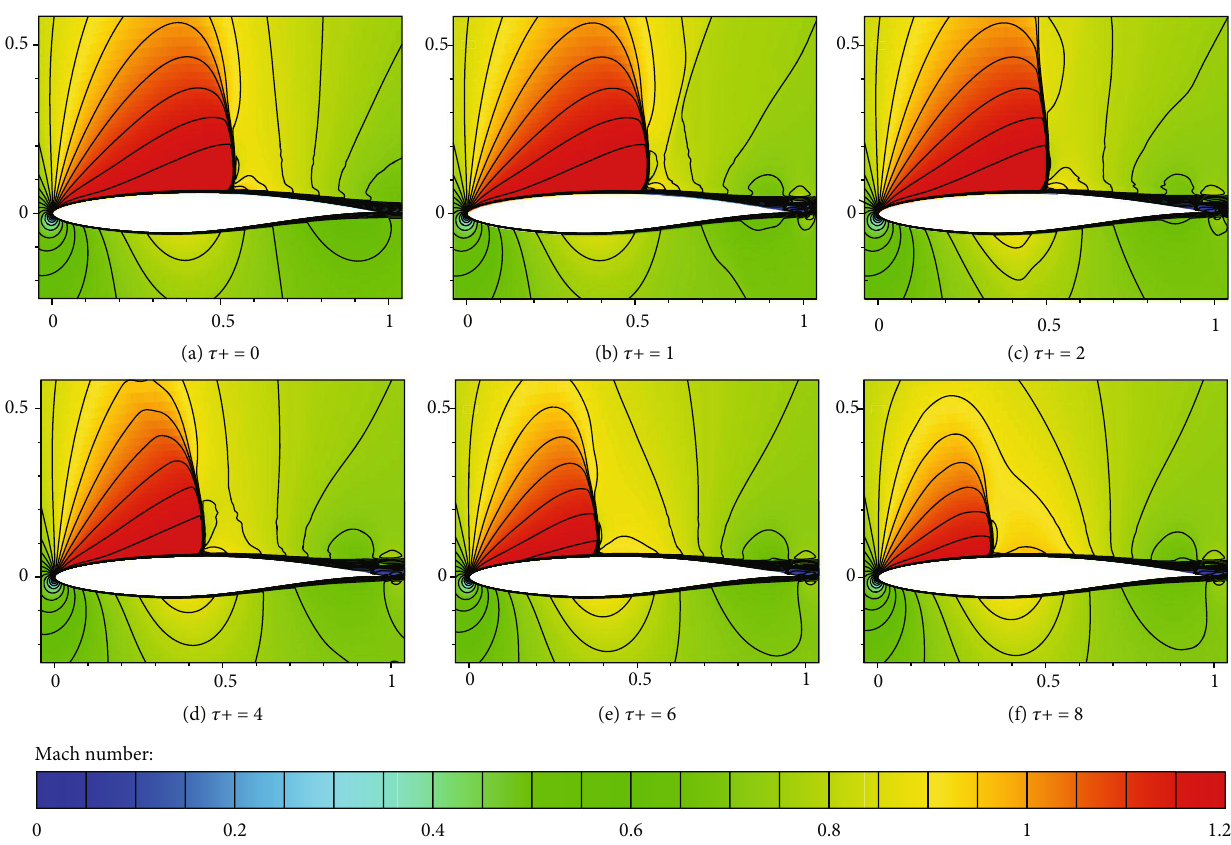
= 0 : 729 , α = 3 ° , θ = 150 ° , and C = 0 : 005 . ∞ j μ